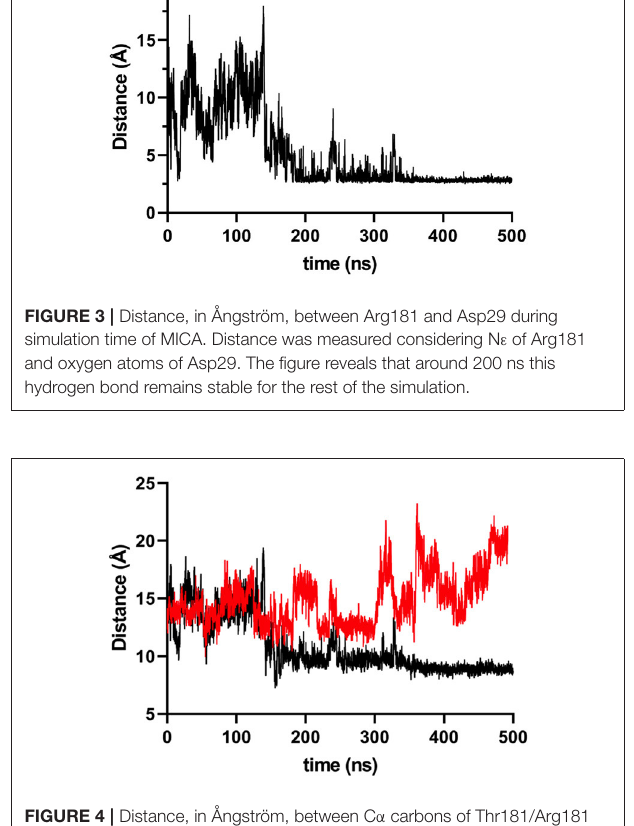
FIGURE 4 | Distance, in Ångström, between C α carbons of Thr181/Arg181 residues and C α of Asp29 on MICA. Black colored line represents Arg181, while red colored line represents Thr181. Around 200 ns, the behavior of alleles differs due the hydrogen bond formation by the Arg181 and the